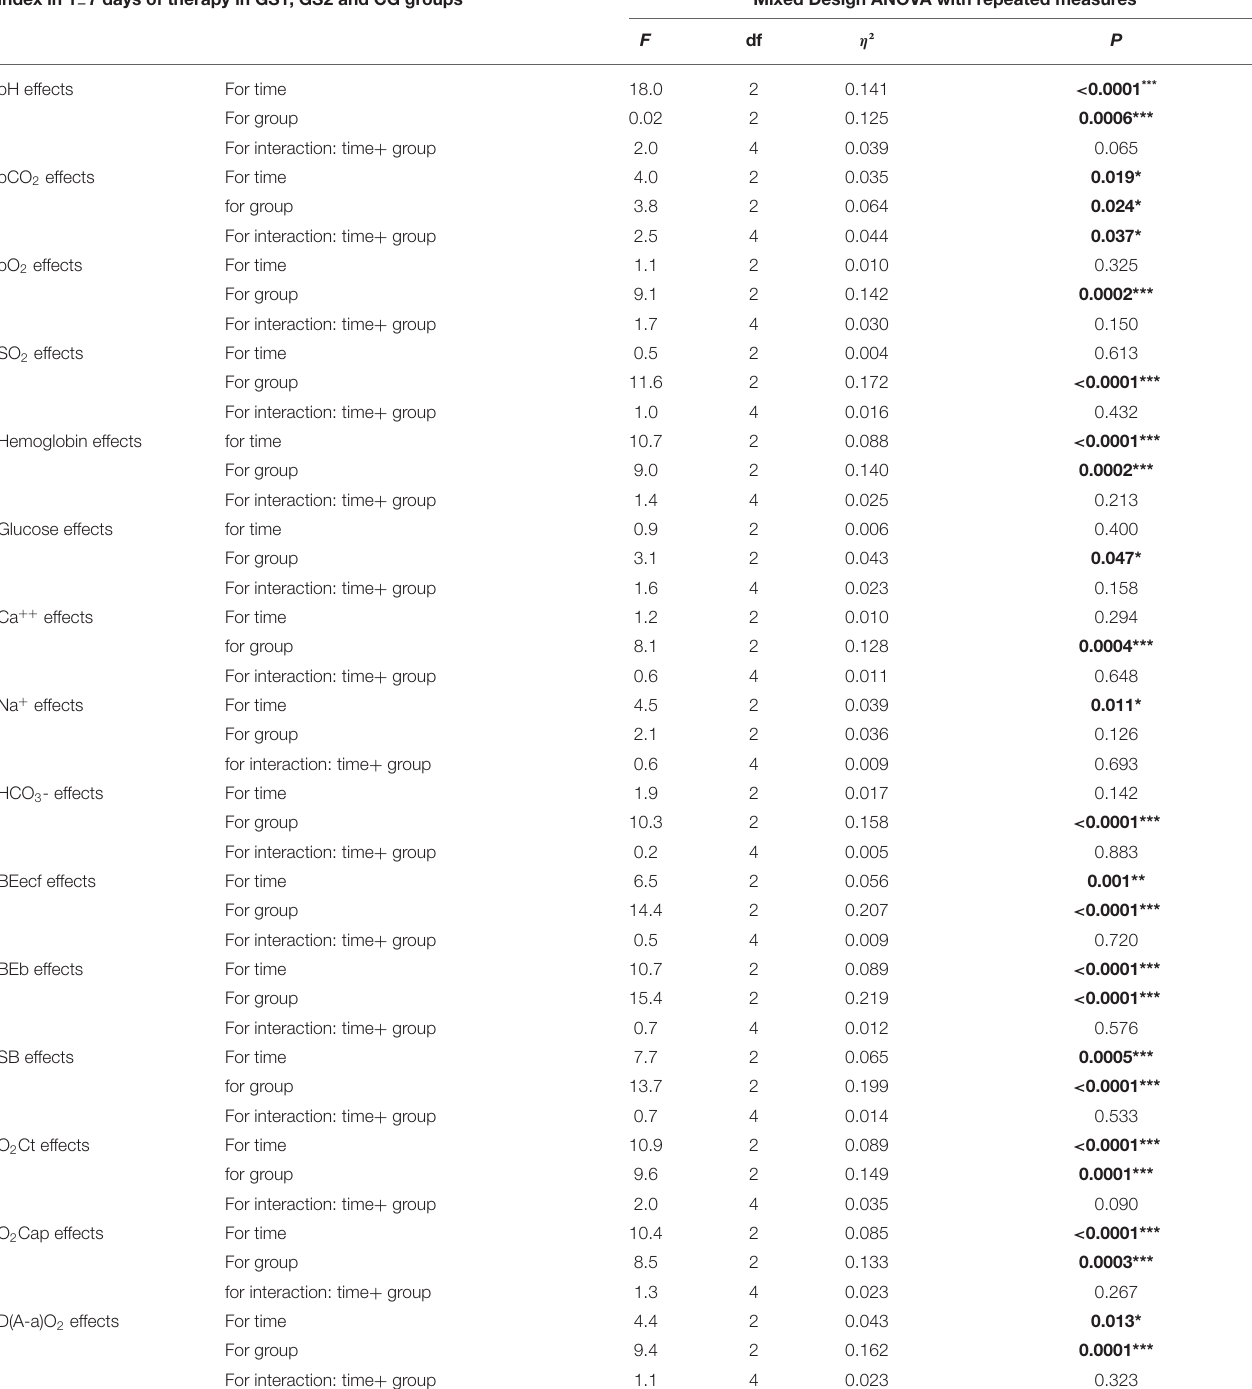
TABLE 3 | Summary of the blood acid-base state results obtained in the mixed design analysis of variance (ANOVA) with repeated measures. Index in 1 − 7 days of therapy in GS1, GS2 and CG